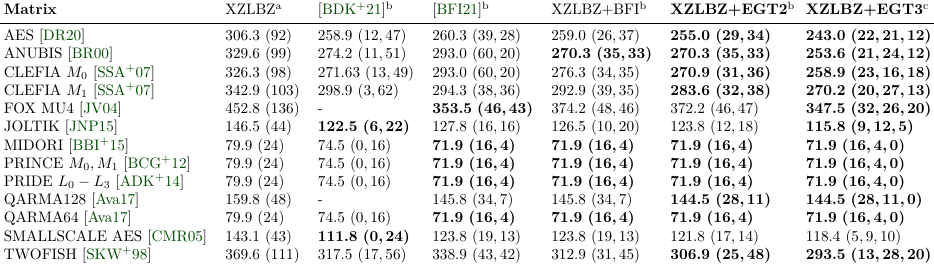
Table 3: The results of implementation cost of matrices in the library named STM 130 nm. The results consist of the circuit area (GE) and the gates. We use “( m )” to represent m 2-input xor gates, use “( m, p )” to represent m 2-input xor gates and p 3-input xor gates, and use “( m, p, q )” to represent m 2-input xor gates and p 3-input xor gates and q 4-input xor gates.